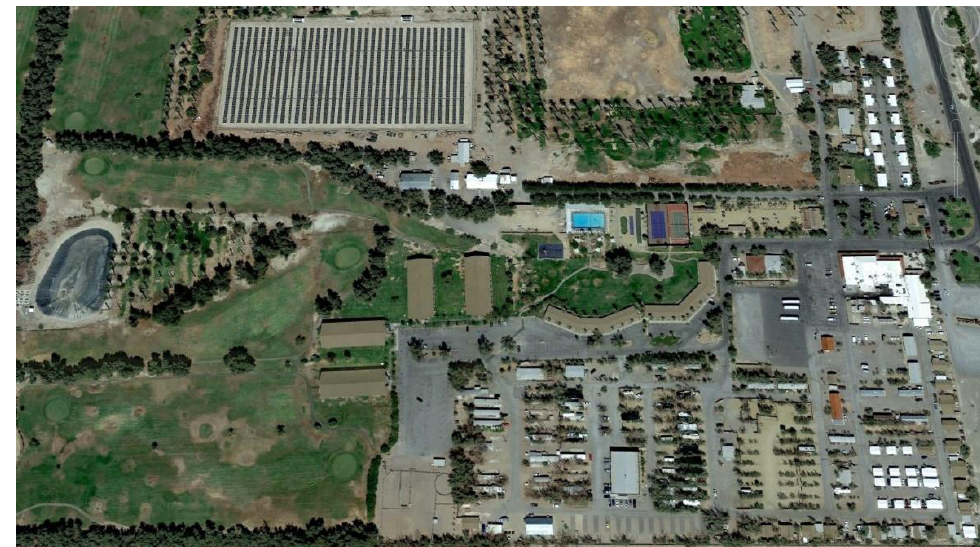
Figure 15. Furnace Creek visitor centre with tennis courts and swimming pool (from Google Earth Pro V 7.3.4, (6 S eptember 2015), 36°27′39.76″N, 116°51′41.36″W, Eye alt 1.39 km, Landsat, Copernicus, CNES, Airbus, Maxar Technologies/USDA/FPAC/GEO 2022, [46]).